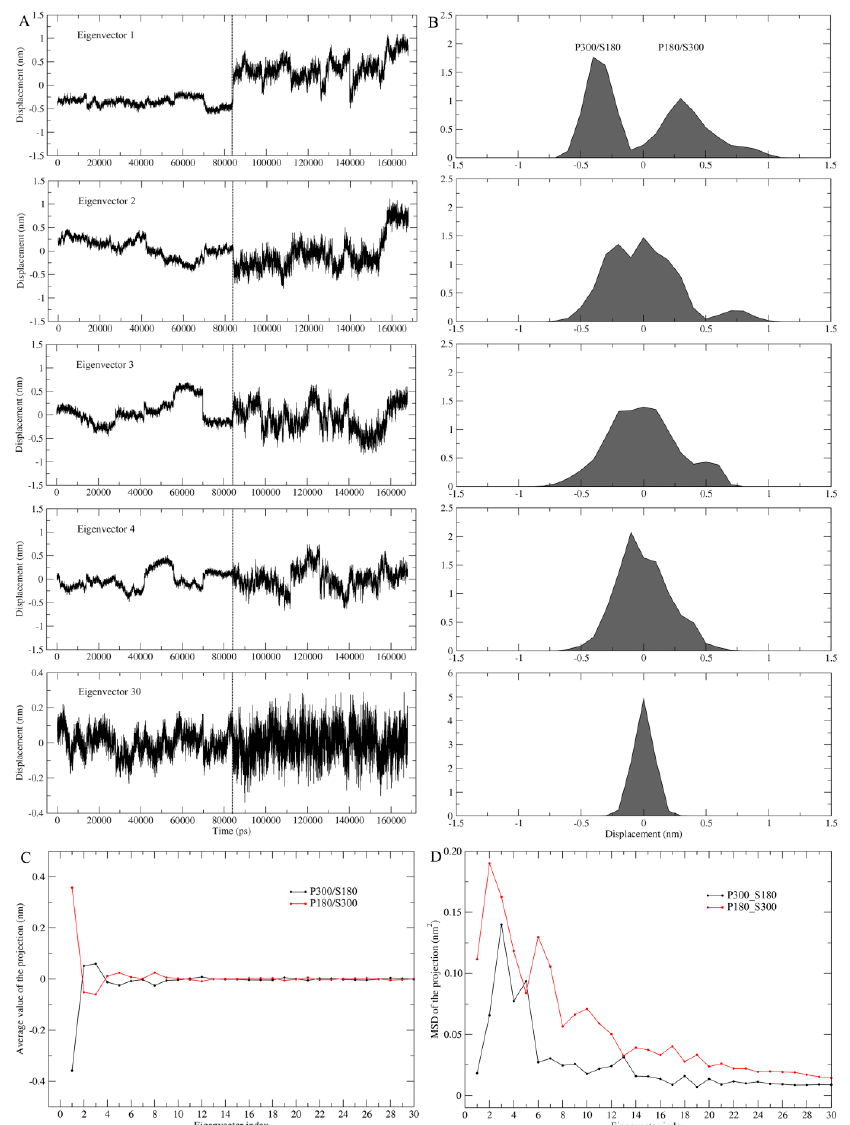
Figure 4. Eigenvector projections and their properties obtained from combined ED analysis of the merged MD trajectories of P300/S180 and P180/S300. ( A ) Projections of the merged